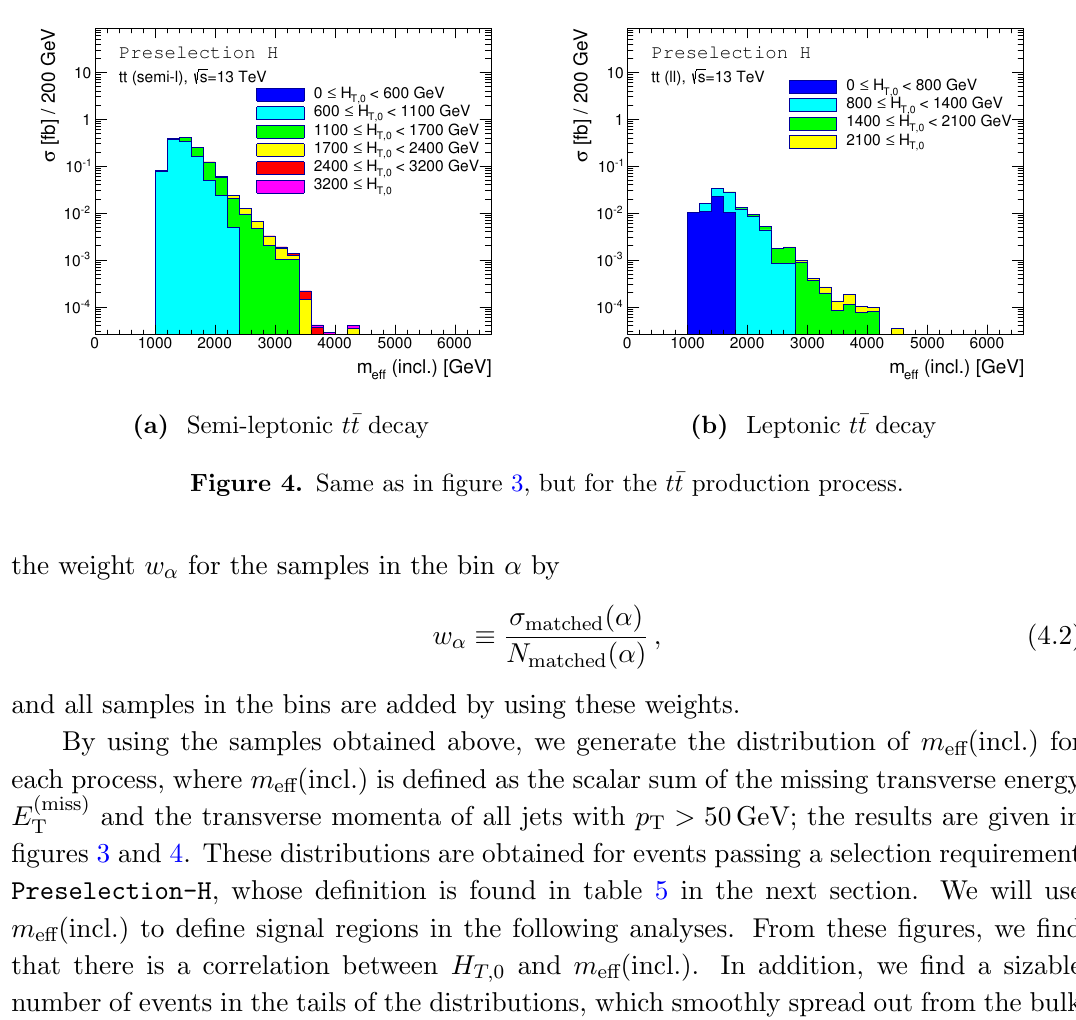
Figure 3. Distributions of m preselection-H required. Contributions from di(cid:11)erent e(cid:11) (incl.) with H T; 0 bins are (cid:12)lled with di(cid:11)erent colors.